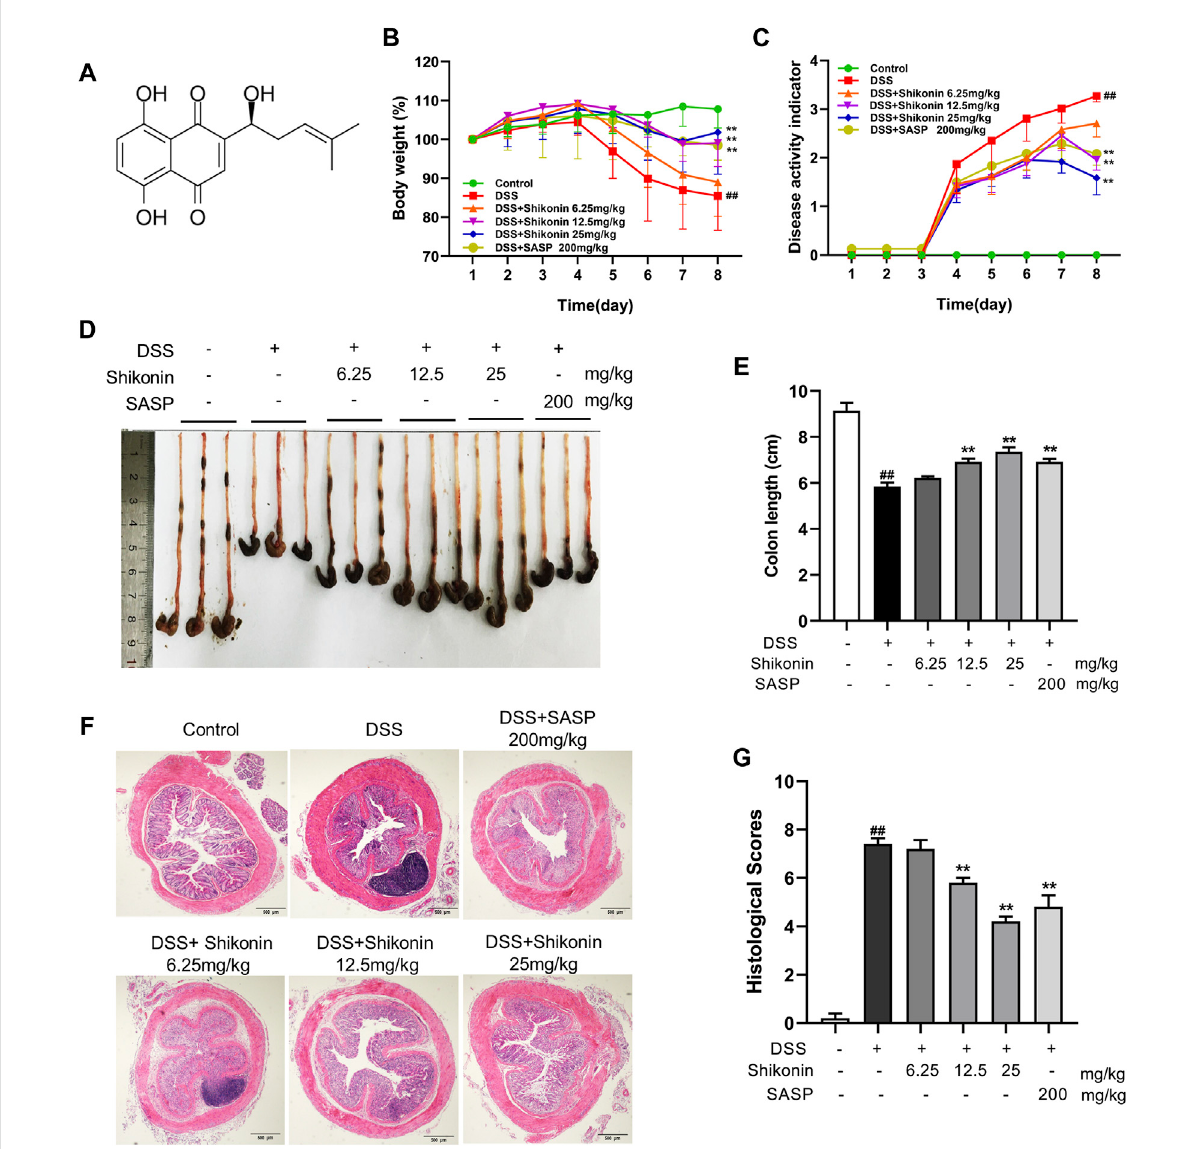
FIGURE 1 Shikonin attenuated the symptoms of DSS-induced mice colitis. Chemical structure of Shikonin (A) . The body weight (B) and disease activity index (DAI) of mice (C) during the course of colitis. Representative images (D) and statistics (E) of colon length in each group. Representative images (F) ofH&E-stainedcolontissuesamples(scalebar,500 μ m)andhistologicalscores (G) ofcolonictissues.Dataareshownasthemean±SD, n =5 – 8. ## p < 0.01, compared to the control group. ** p < 0.01, compared to the DSS